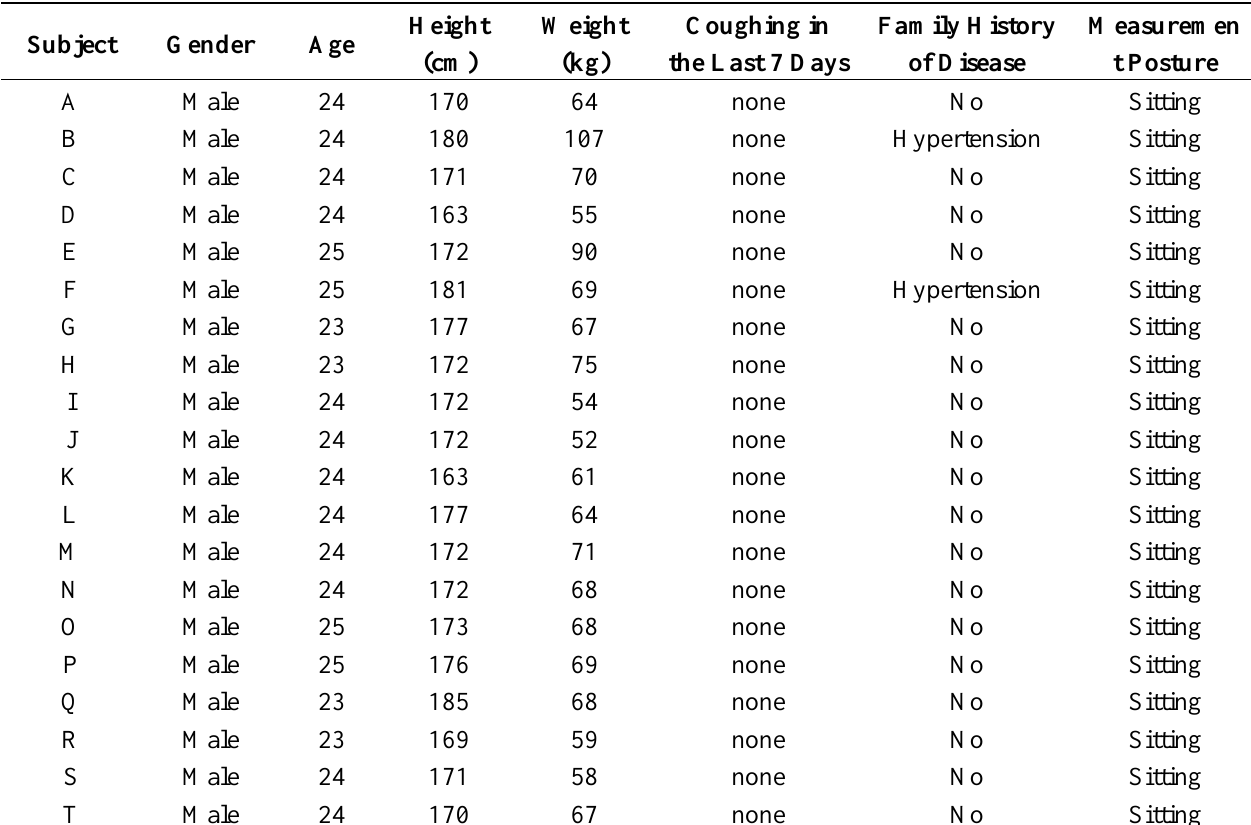
Table 10. Basic information of twenty subjects.